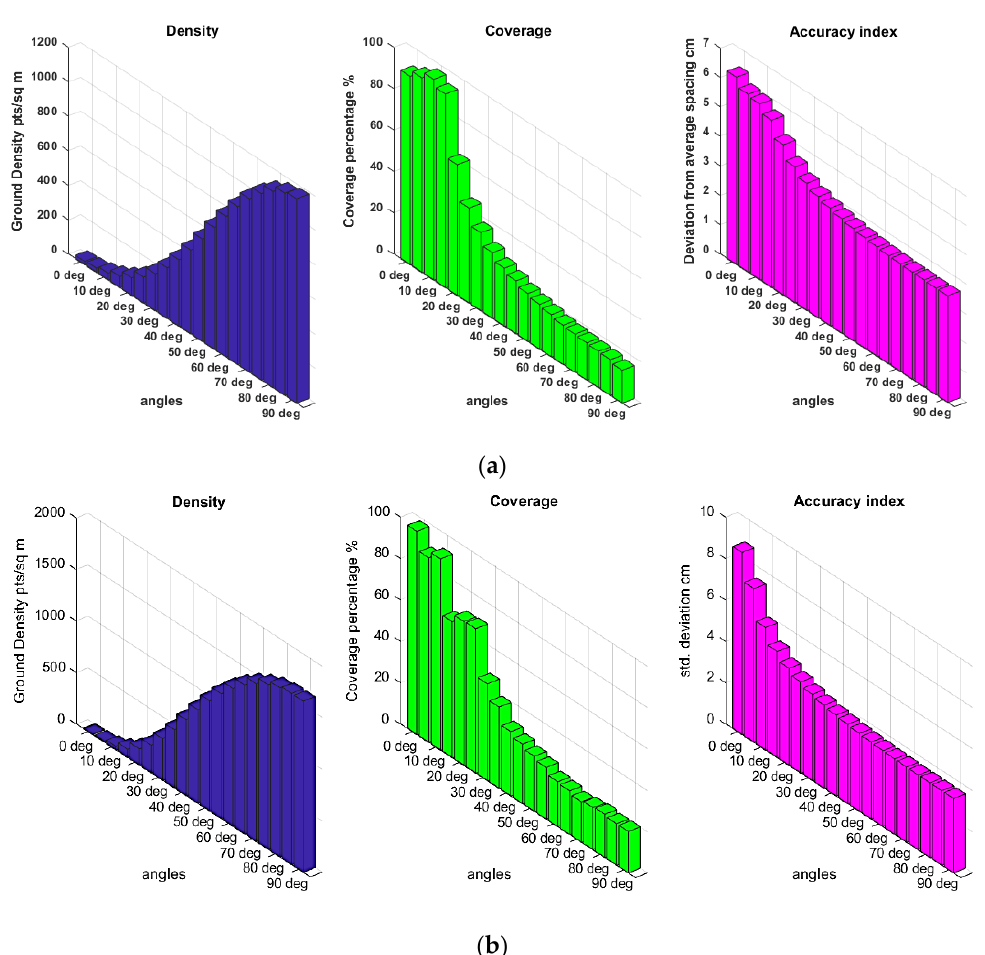
Figure 9. Performance test of the individual scans. ( a ) OS-1-64. ( b ) Pandar64.